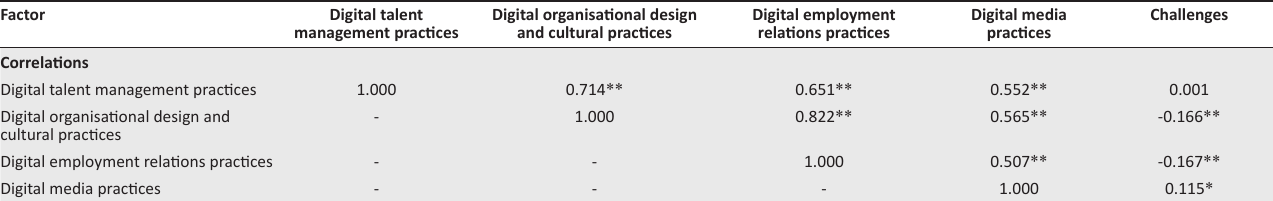
TABLE 3: Correlation analysis: Challenges and digital human resource management practices. Factor